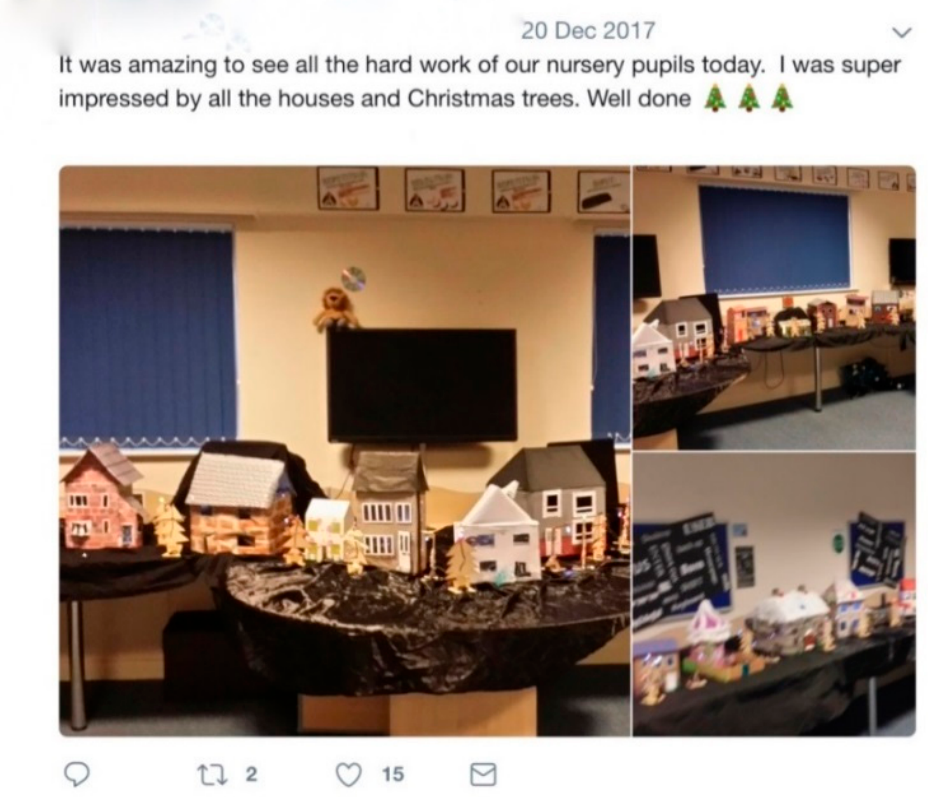
Figure 6. A tweet from a school governor about the exhibition.